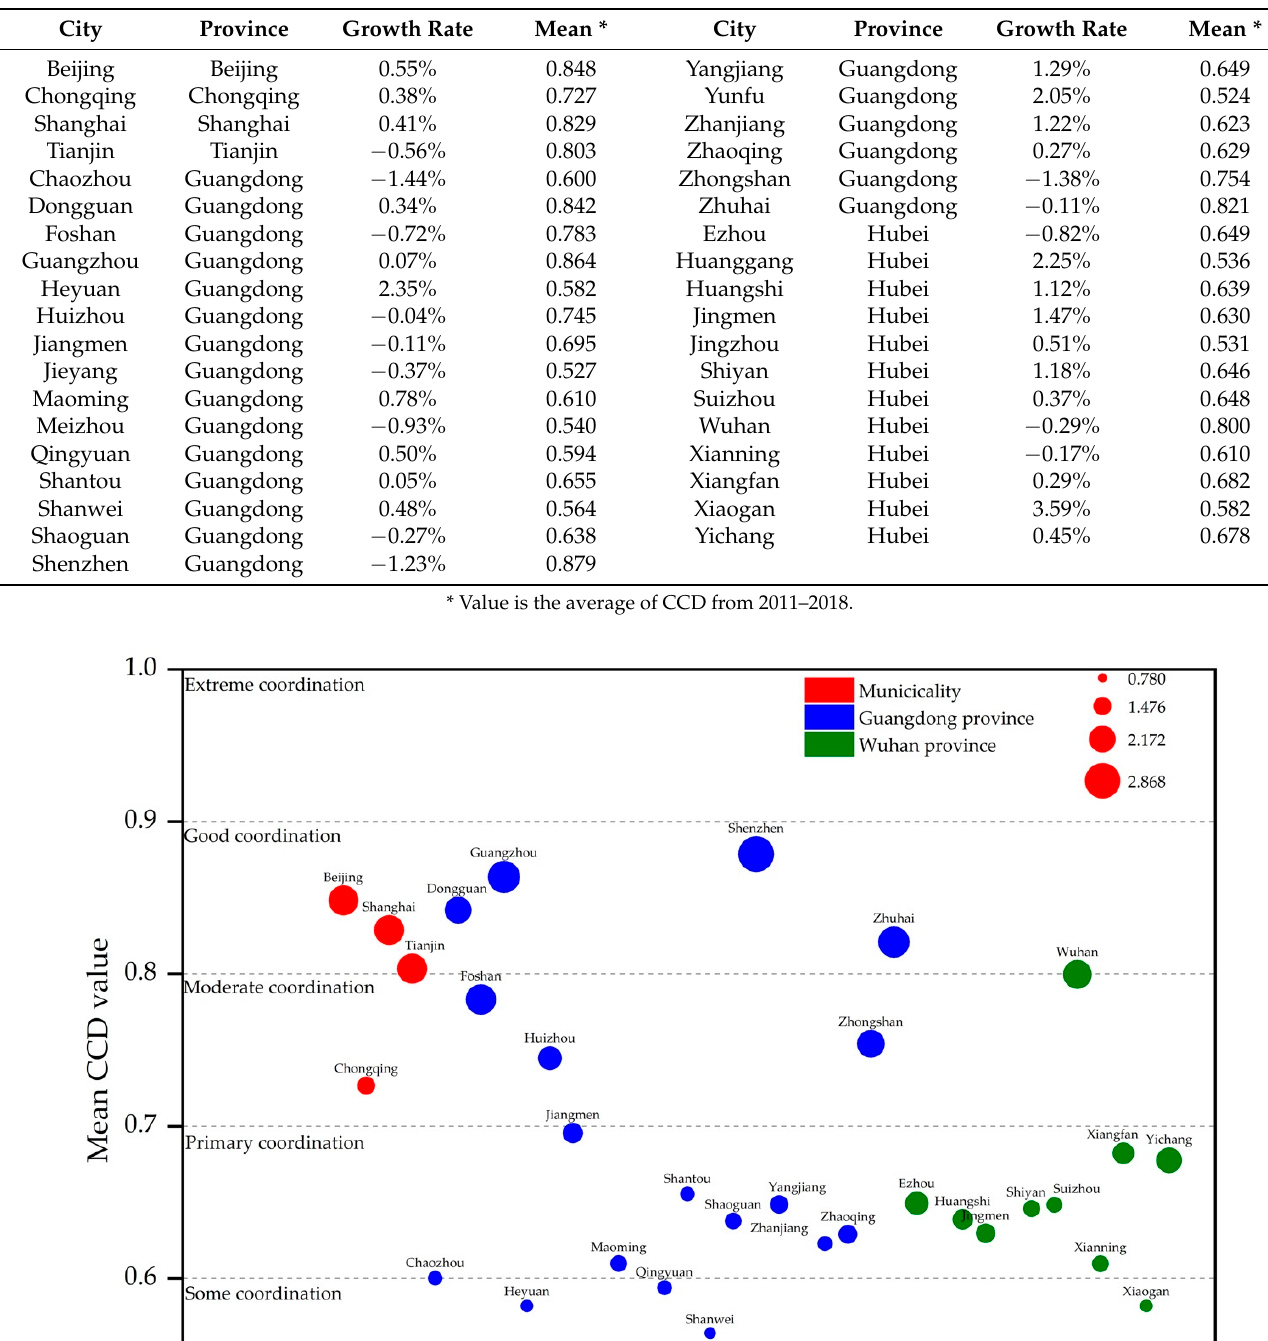
Table 3. The growth rate and mean of CCD values for economic development and environmental quality.